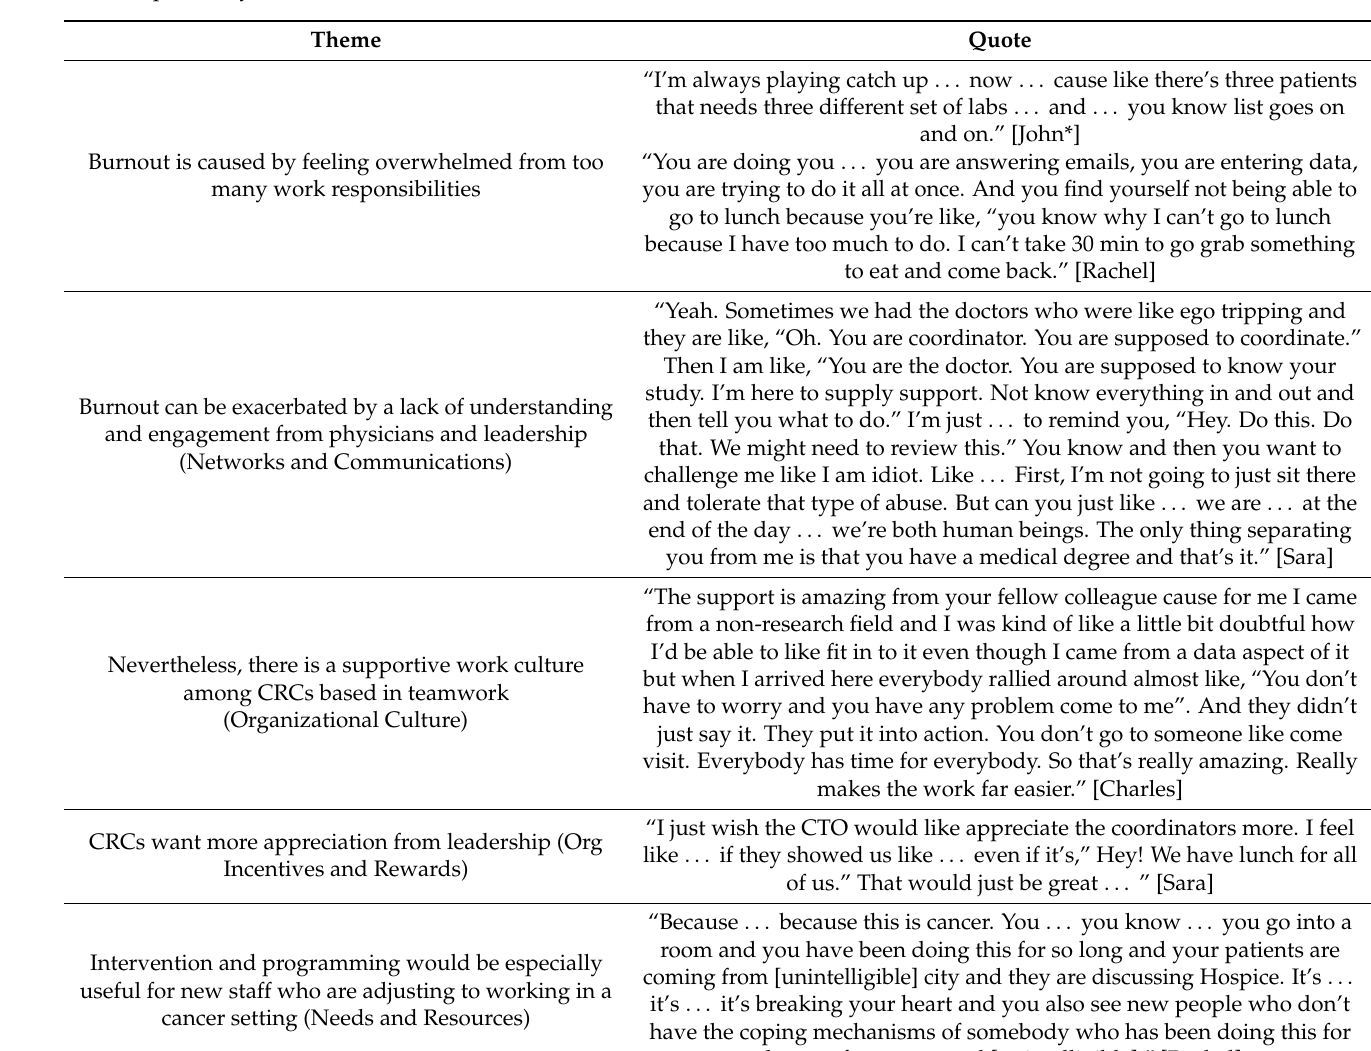
Table 5. Summary of themes from qualitative analysis. CFIR constructs listed in parentheses under each theme. * All names are